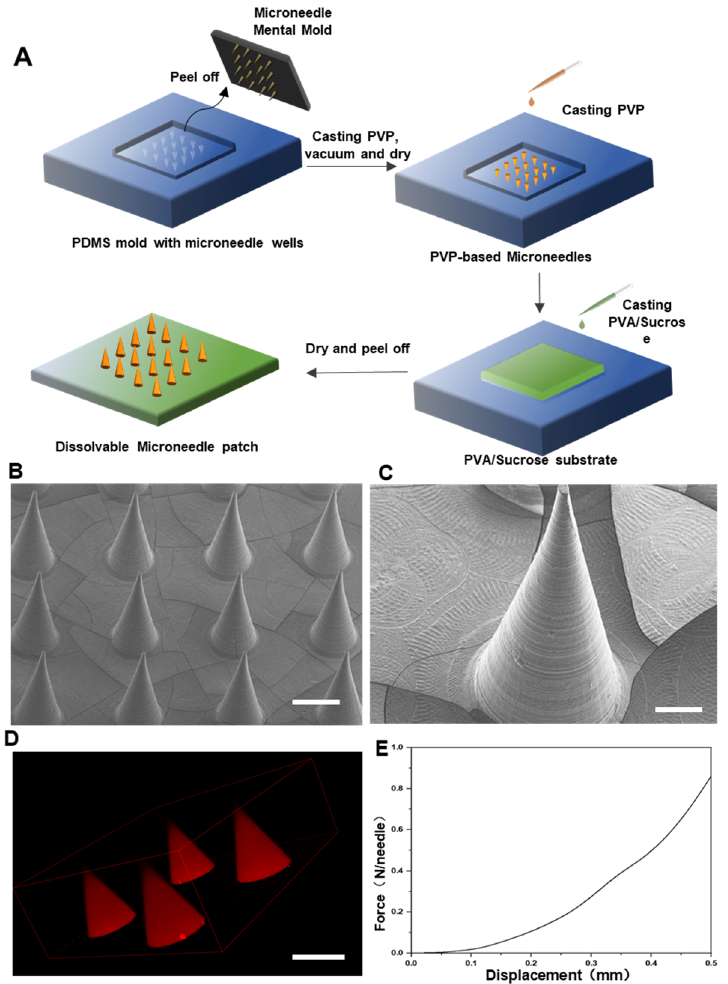
Figure 2. Characterization of MNs. ( A ) Preparation scheme of a drug NP-loaded MN. ( B ) SEM images of MNs. Scale bar: 300 µ m. ( C ) SEM images of MNs. Scale bar: 100 µ m. ( D ) Laser confocal microscopy image of MNs. Scale bar: 300 μ m. ( E ) Mechanical strength of MNs and photograph after compression.